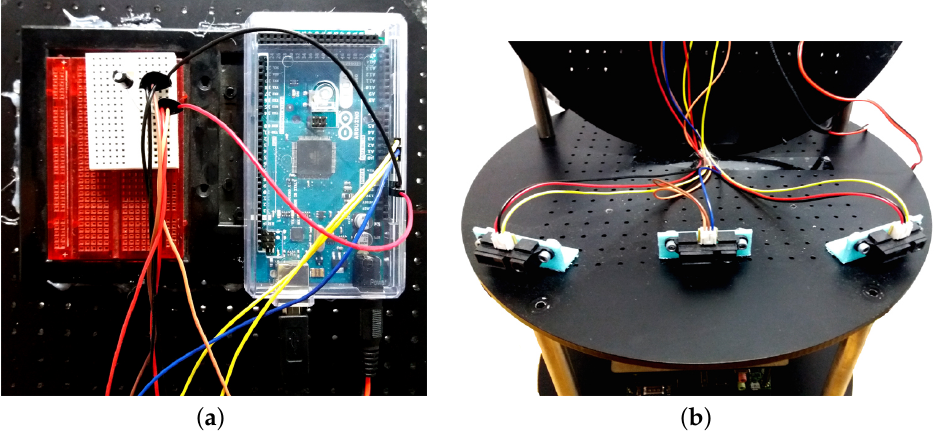
Figure 12. Sensor fusion and state generation. ( a ) An Arduino mega board is used to connect the infra red proximity sensors to Nvidia TK1 board; ( b ) Infra red proximity sensors used as range